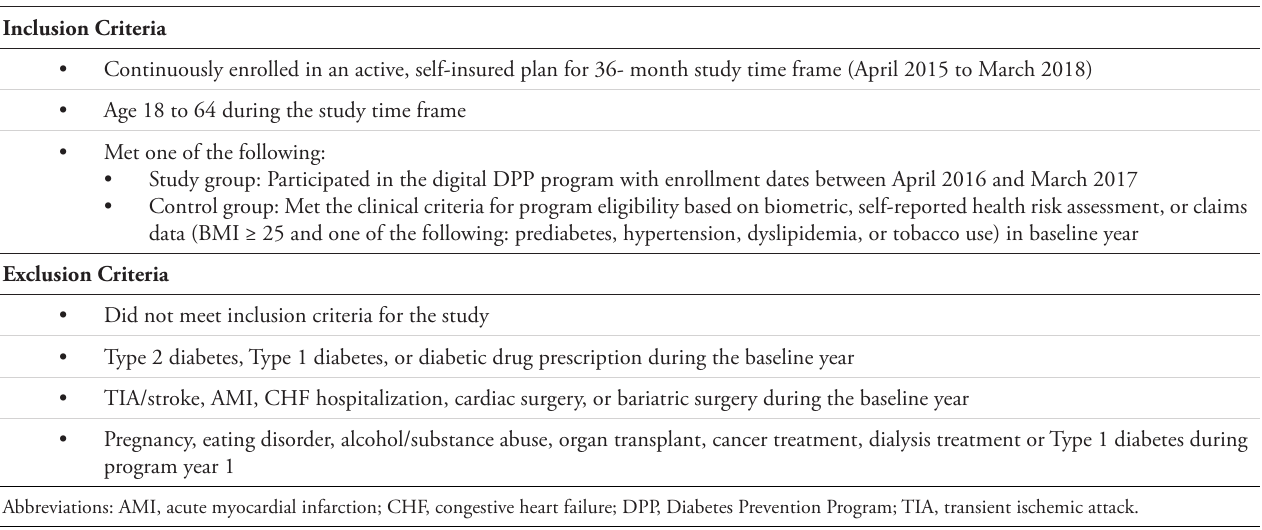
Table 1. Inclusion & Exclusion Criteria